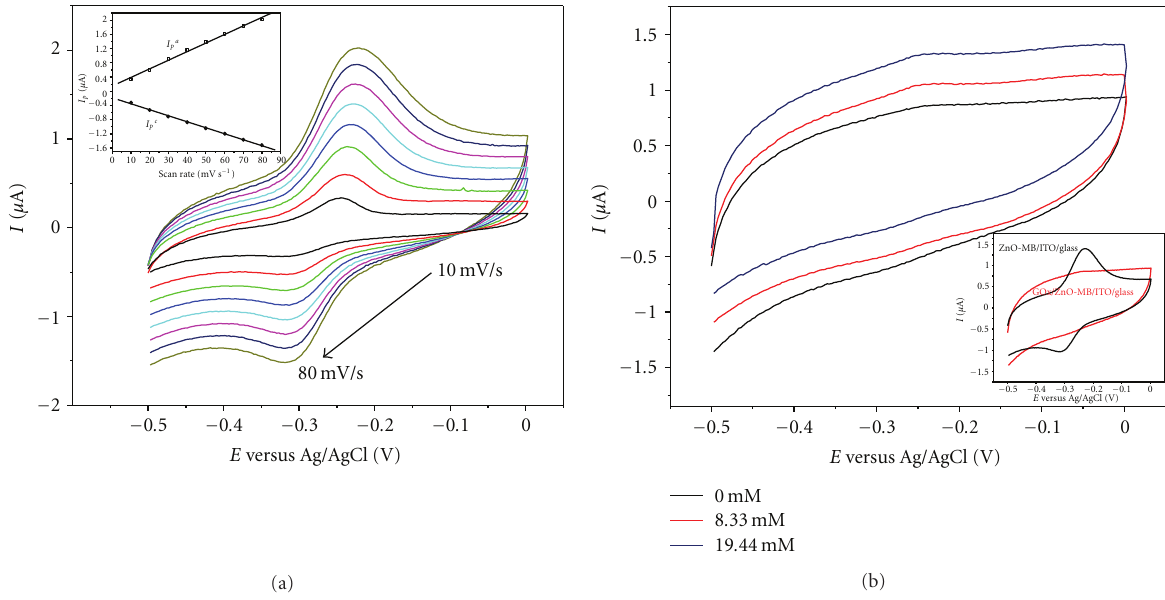
Figure 5: (a) Cyclic voltammograms of ZnO-MB/ITO film at di ff erent scan rate (inset shows the variation of anodic and cathodic peak current with potential scan rate) (b) CV of GOx/ZnO-MB/ITO bio-electrode with di ff erent glucose concentration (Inset shows CV of ZnO- MB/ITO and GOx/ZnO-MB/ITO